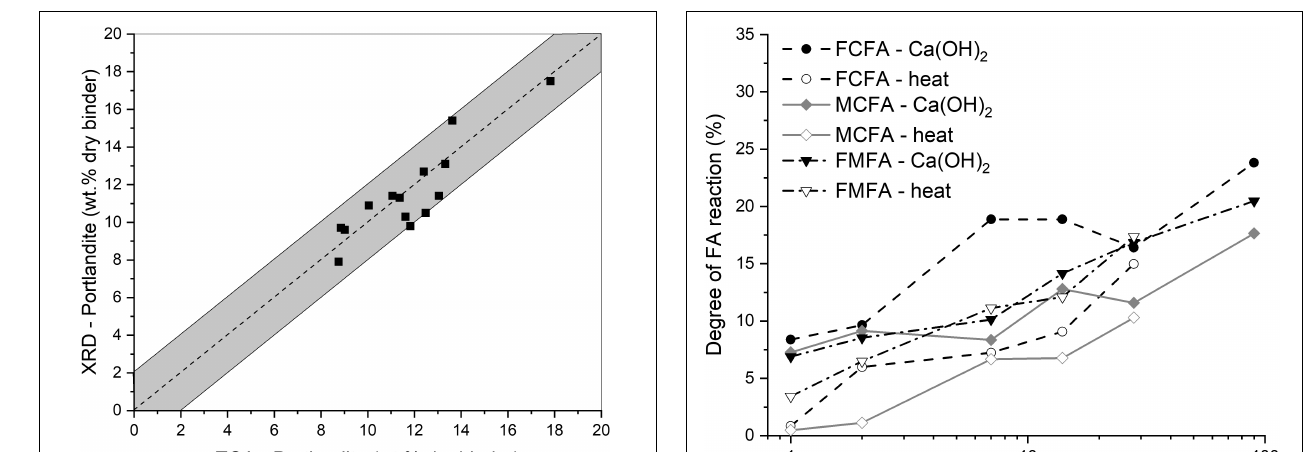
Frontiers in Built Environment |